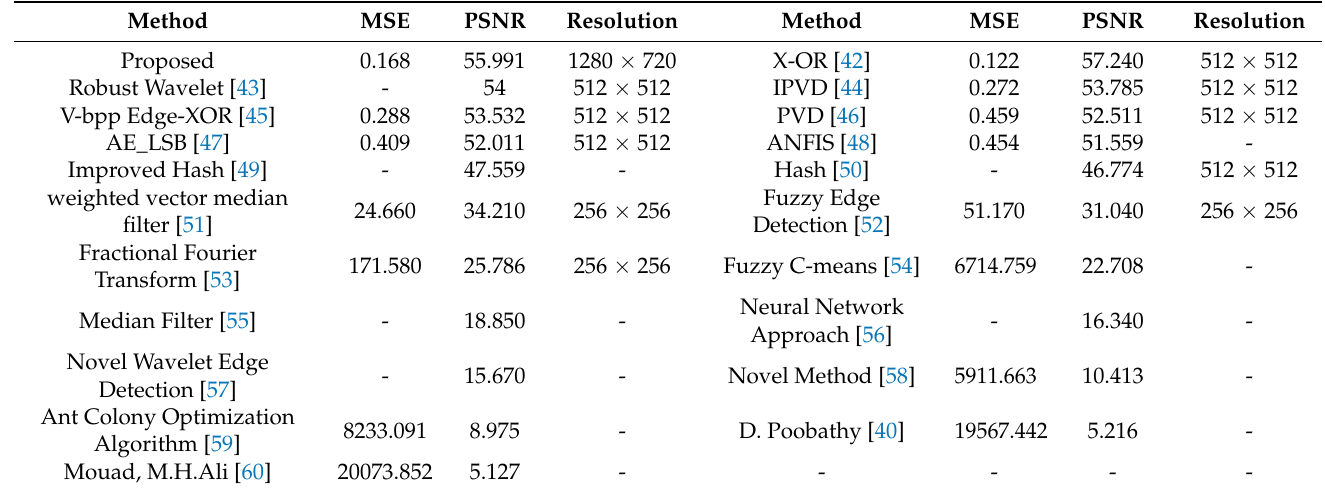
Figure 7. We can see the edge result images without our method (pre-processing about brightness and contrast control) and them with: ( a ) original image; ( b ) Ground Truth; ( c ) Edge detection result with only Canny algorithm; ( d ) Edge detection result with our method. Table 2. The Comparison with other edge detection